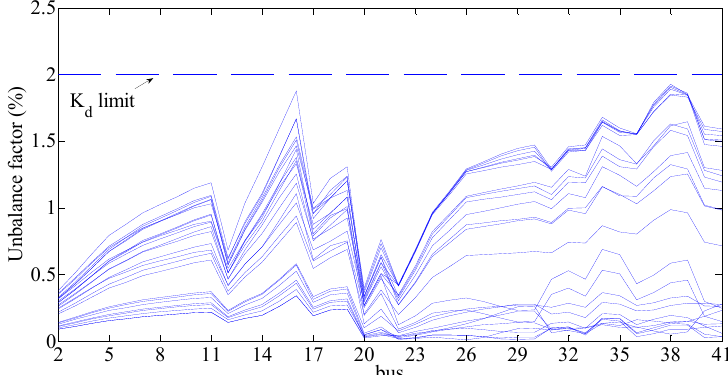
Figure 7. Case Study 2: Unbalance factor at each hour of the last typical day. Appl. Sci. 2018 , 8 , x FOR PEER REVIEW